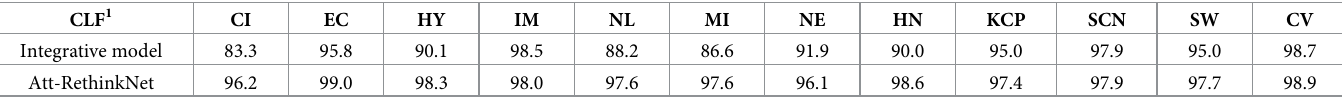
Table 11. ACC lab of the integrative model and Att-RethinkNet for liver data. CLF 1 CI EC Integrative model